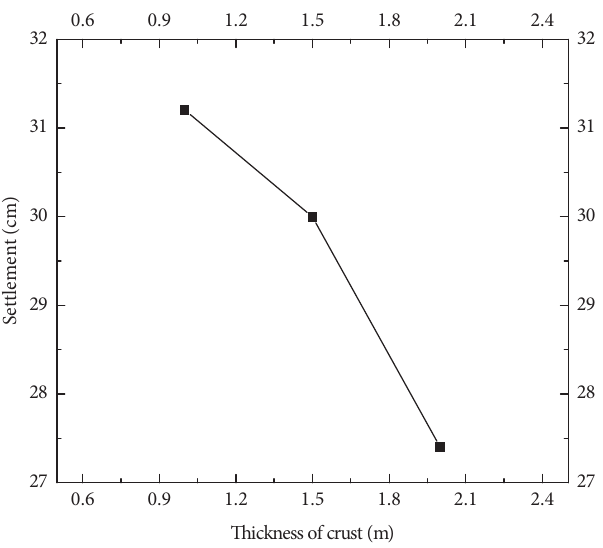
Figure 9: Settlement versus thickness of